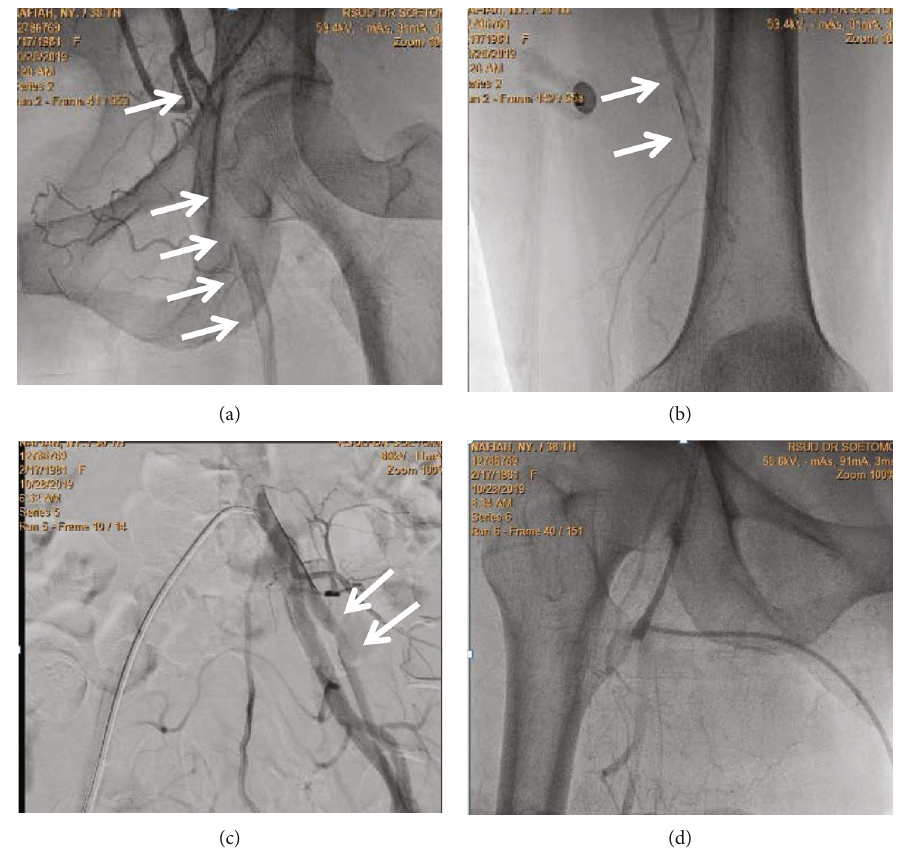
Figure 2: Arteriographic fi ndings of the inferior extremities show that di ff use thrombus was visualized in the left common femoral artery (a) continuing until the super fi cial femoral artery and distal femoral artery (b). A thrombus appears on left external iliac artery (c). Contrast fl ow is normal in the right inferior limb